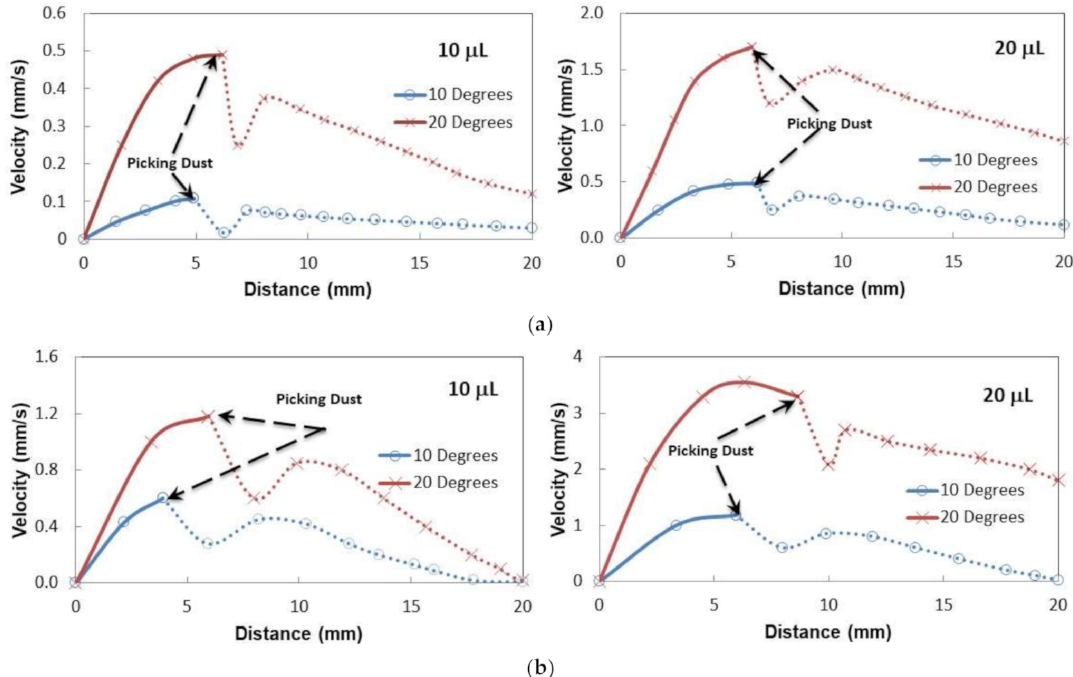
Figure 9. ( a ) Droplet sliding velocity on inclined oil impregnated surface with the large dust particle presence for two droplet volume and tilting angles. Oil film thickness is 50 µ m. ( b ) Droplet sliding velocity on inclined oil impregnated surface with large dust particle presence for two droplet volume and tilting angles. Oil film thickness is 700 µ m.